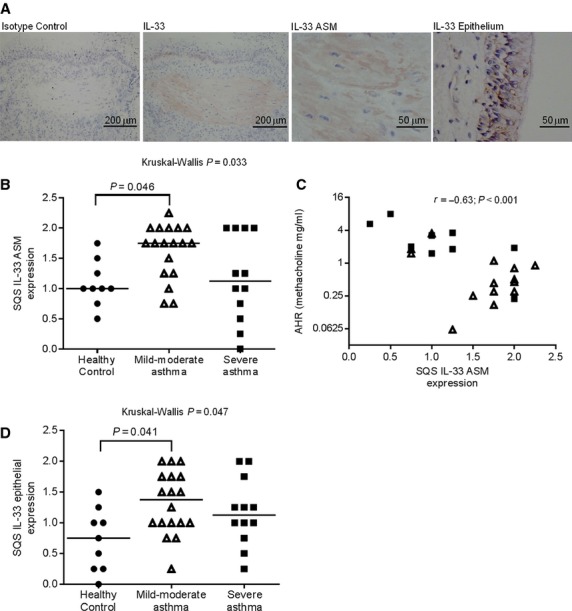
ASM and bronchial epithelial IL-33 expression (A) Representative photomicrographs of bronchial biopsies from an asthmatic subject illustrating isotype control, IL-33+ cell staining in ASM, submucosa (original magnification ×100), and within the ASM-bundle and epithelium (original magnification ×400). (B) Semi-quantitative scoring (SQS) of ASM IL-33. (C) Correlation between SQS ASM IL-33 and AHR in subjects with asthma. (D) Semi-quantitative scoring (SQS) of bronchial epithelium IL-33. • = healthy control, ▵ = mild–moderate asthma, ▪ = severe asthma. Horizontal bars represent the median, P < 0.05, Kruskal–Wallis test, for all across-group comparisons.